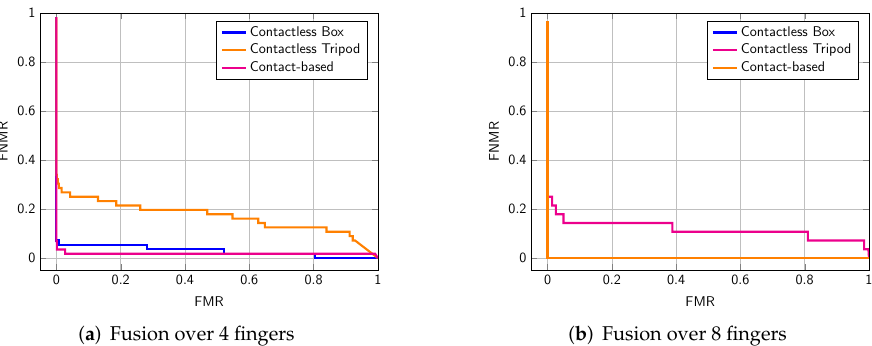
Figure 11. DET curves obtained in a fingerprint fusion approach: Fusion over the 4 inner-hand fingers of the left hand (IDs 2–4) and right hand (IDs 7–10) fusing ( a ) and fusion over 8 fingers of both inner hands (IDs: 2–4, 7–10) ( b ).